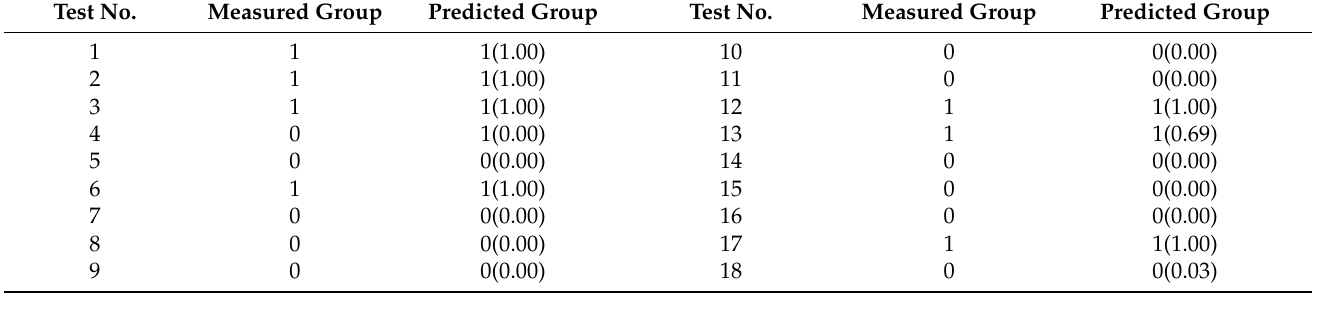
Table 10. Results of group discriminant for weldment hardening according to SVM. Test No.